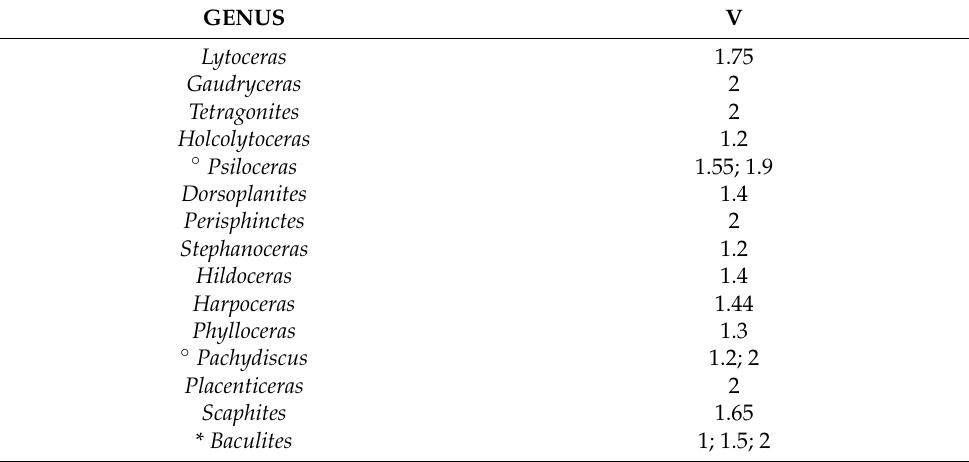
Table 3. Conversion values (V) for common genera of Jurassic and Cretaceous ammonites (File S1 of the Supplementary Materials for this manuscript). Single V values indicate cases where all species all of a genus cluster around this single V value. Double Vs indicate genera in which some species cluster around one value while other species are associated with the second V value; ◦ indicates a double V; * indicates a triple